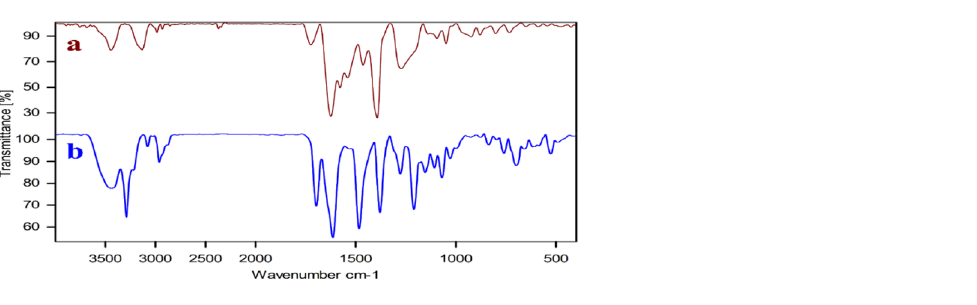
Figure 9. FT-IR spectra of the ( a ) fresh Ag–CP and ( b ) spent